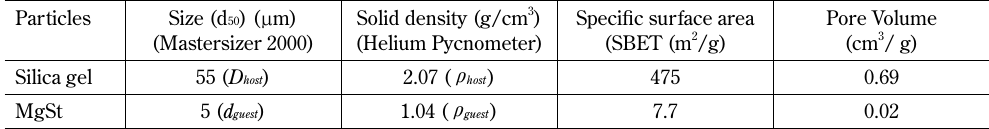
Table1 Properties of host and guest particles